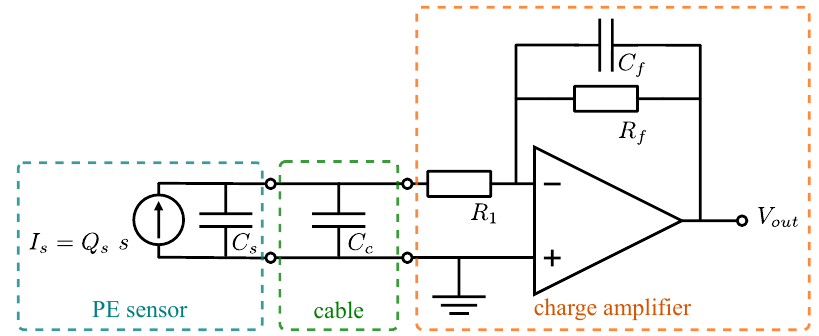
Figure 2. Electric circuit of piezoelectric sensor connected to charge